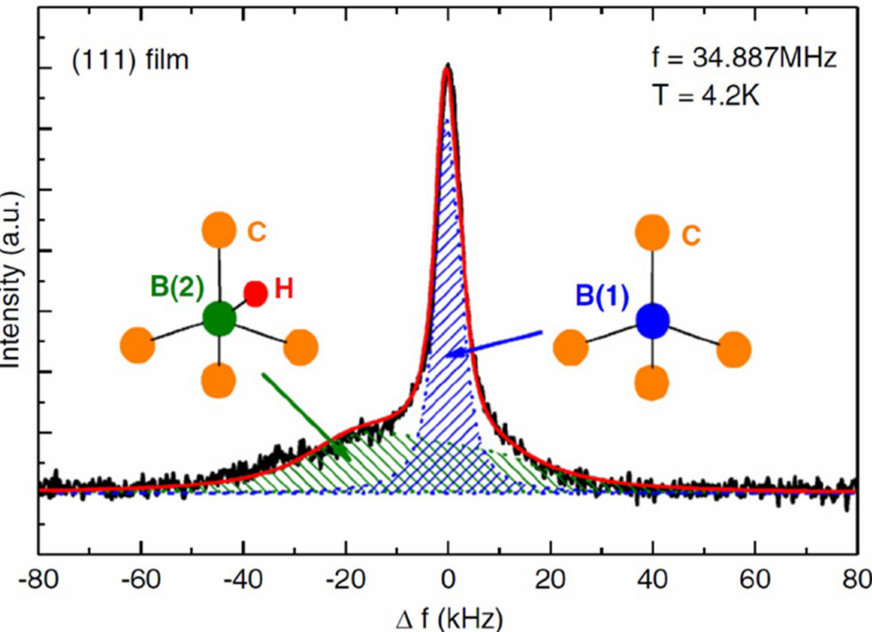
Figure 1. 11 B NMR spectrum for the (111) film, the fitted red curve shows 2 boron sites, which are identified as B(1) blue and B(2) green, respectively. Reproduced with permission [73]. Copyright 2006, Taylor & Francis. www.tandfonline.com. (accessed on April